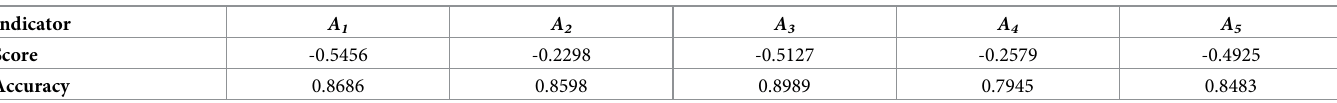
Table 5. The calculated scores and accuracies.